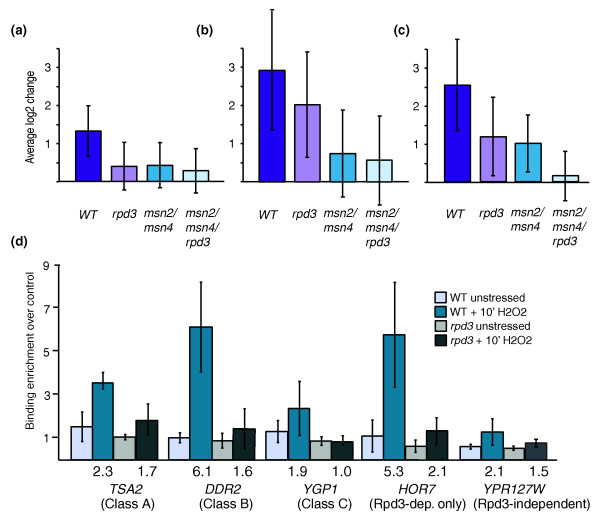
Rpd3p is required for proper Msn2/4p action. (a-c) Gene expression measured in wild-type (WT), rpd3Δ, msn2Δ /msn4Δ, and msn2Δ /msn4Δ /rpd3Δ cells treated with 0.4 mM H2O2 for 30 minutes. Average log2 expression changes of (a) 215 genes equally affected by deletion of RPD3, MSN2/MSN4, or MSN2/MSN4/RPD3, (b) 83 genes affected more by deletion of MSN2/MSN4 than RPD3, and (c) 103 genes that display additive dependence on RPD3 and MSN2/MSN4. The standard deviation of the genes' expression is shown for each gene group. (d) Msn2p binding before and 10 minutes after 0.4 mM H2O2 treatment in wild-type and rpd3Δ cells, according to the key for: TSA2 (from (a)), DDR2 (from (b)), YGP1 (from (c)), HOR7 (dependent on Rpd3p only), and YPS127W (dependent on Msn2/4p but not Rpd3p). Fold-change in Msn2p occupancy between stressed and unstressed cells is listed below each plot. Error bars represent the standard deviation of triplicate experiments.